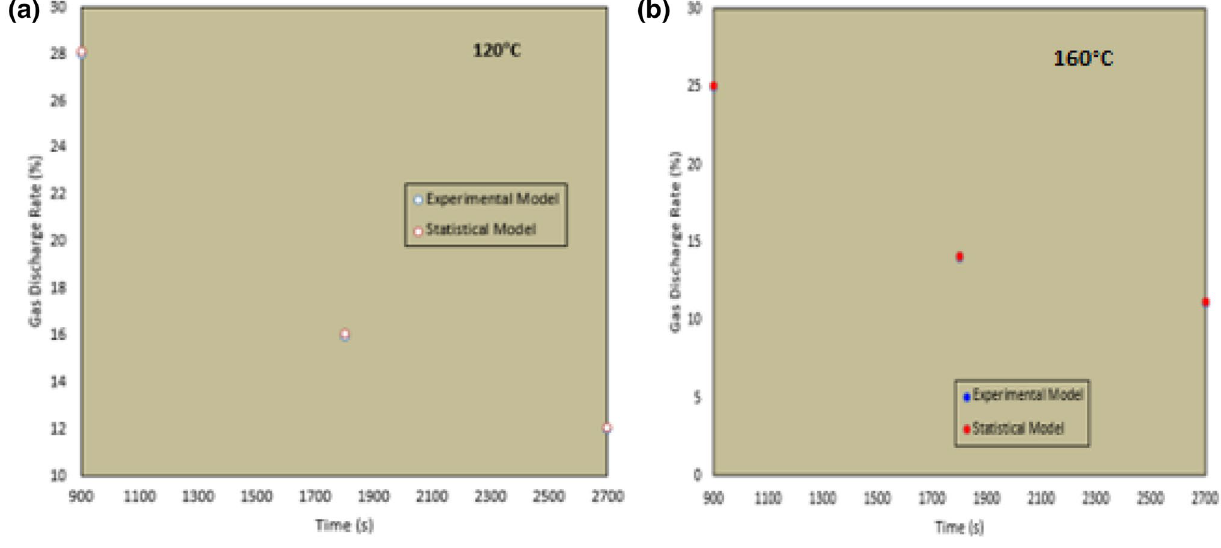
Fig. 9 Model validation, a 120 °C, b 160